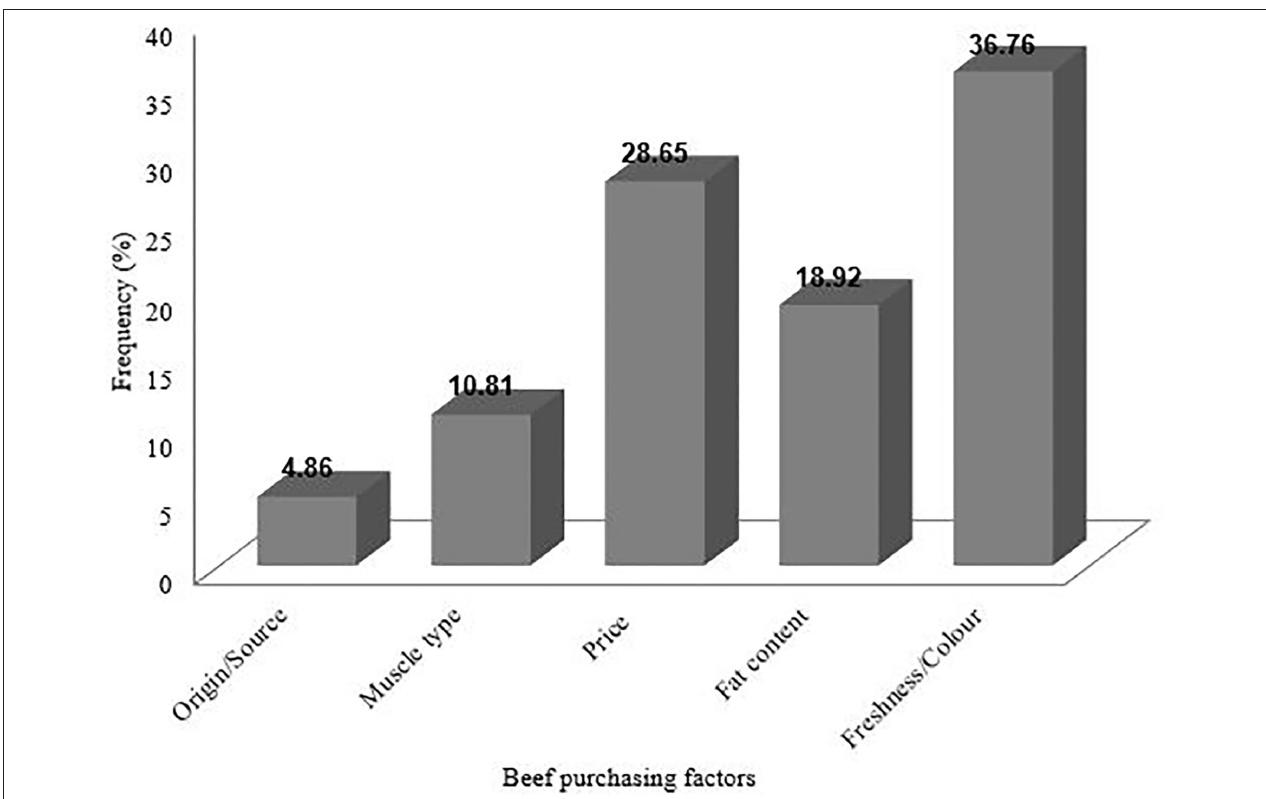
FIGURE 2 | Factors influencing the purchase of beef for consumption in the Eastern Cape province of South Africa.